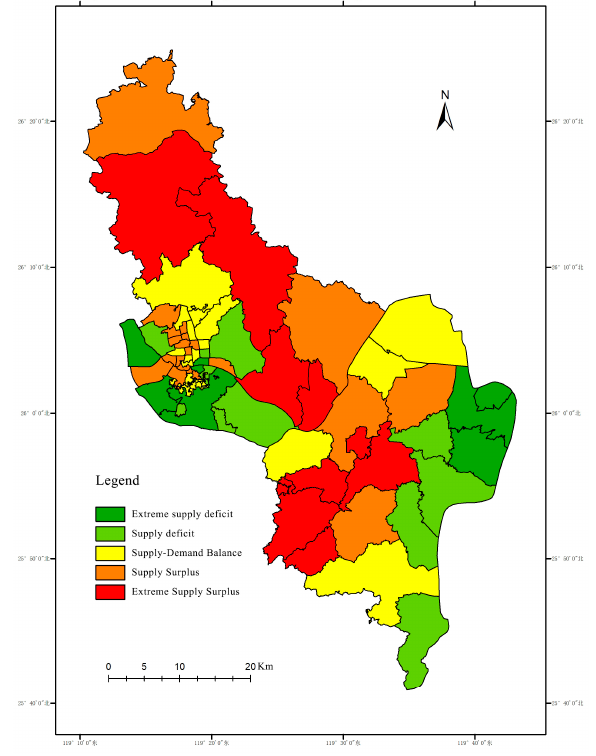
Figure 17. Fuzhou city’s green space supply and demand balance results.